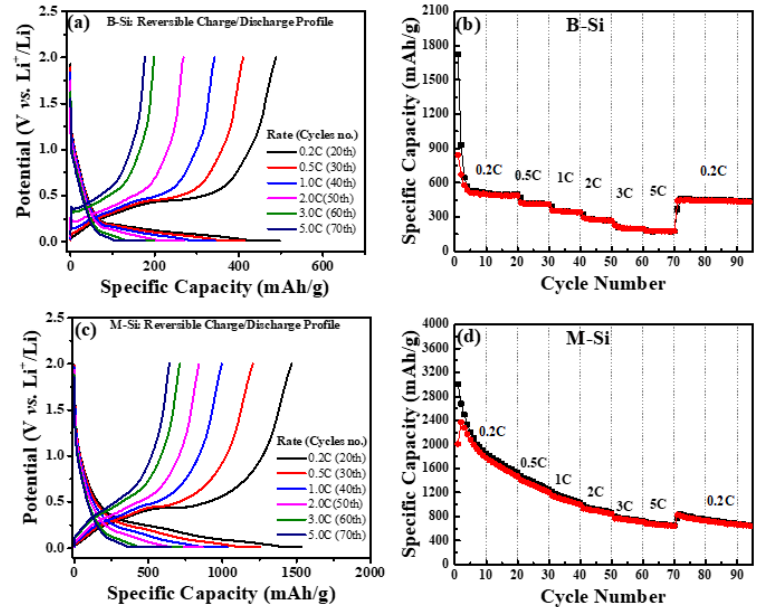
Figure 9. Charge/discharge curves of ( a ) B-Si and ( c ) M-Si electrodes at 20th, 30th, 40th, 50th, 60th, and 70th cycles. Rate capability tests of ( b ) B-Si and ( d ) M-Si electrodes under different current den- sities of 0.2C, 0.5C, 1C, 2C, 3C, 5C, and 0.2C.